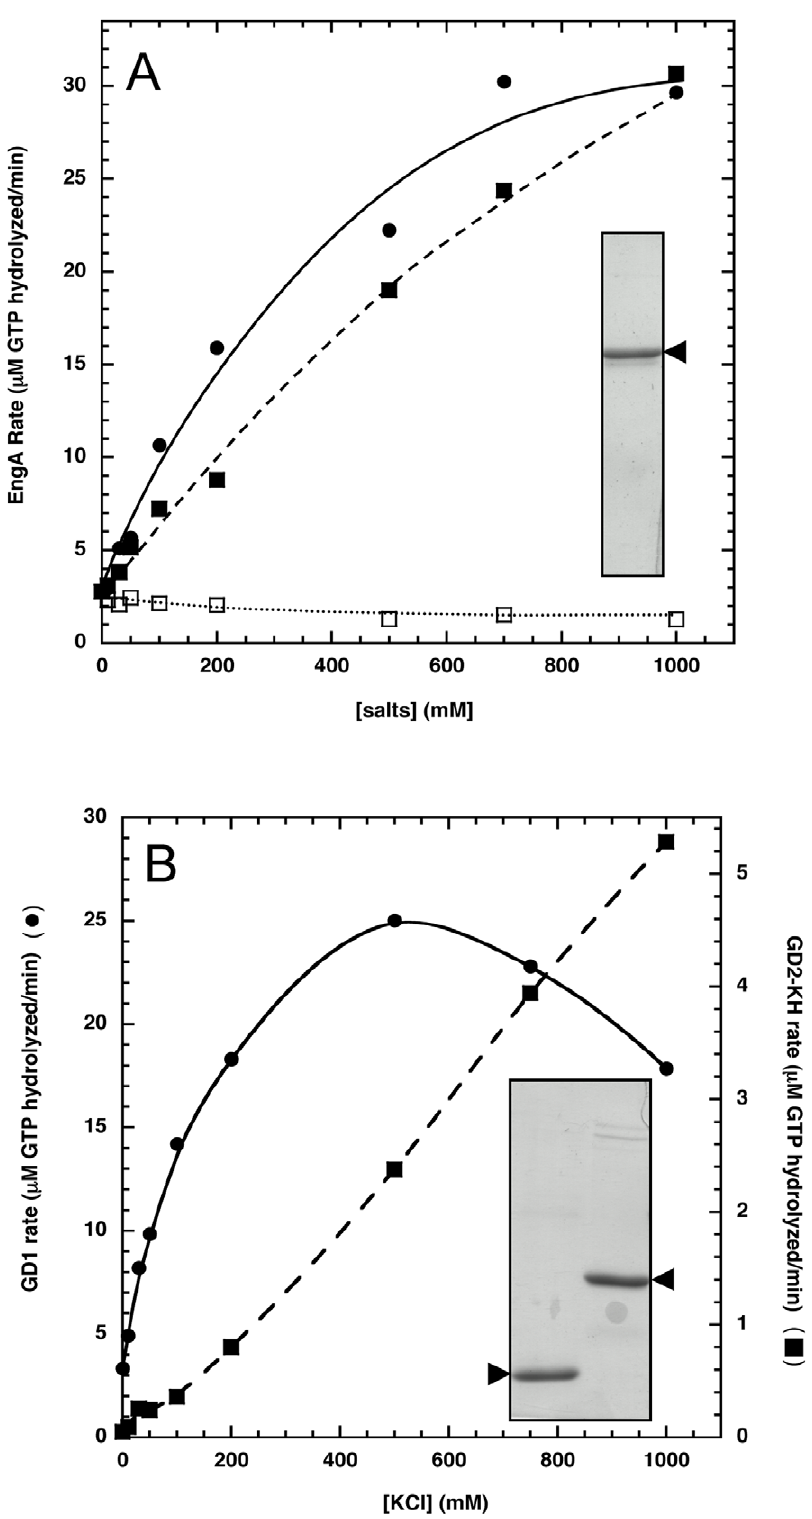
Figure 1. Salt effects on the GTPase activity of EngA, GD1 and GD2-KH. A , the GTPase activity of EngA was monitored in the presence of 1 mM of GTP and KCl (closed circles), RbCl (closed squares), or NaCl (open squares); insert shows a SDS-PAGE of the purified EngA (indicated by a black arrowhead) which migrated close to its predicted molecular weight of 50.9 kDa). B , the GTPase activity of GD1 (closed circles, left scale) or GD2-KH (closed squares, right scale) was monitored in the presence of KCl; insert shows a SDS-PAGE of the purified proteins, indicated by black arrowheads: left lane, GD1 (predicted molecular weight of 20.7 kDa); right lane, GD2-KH (predicted molecular weight of 32.1 kDa).